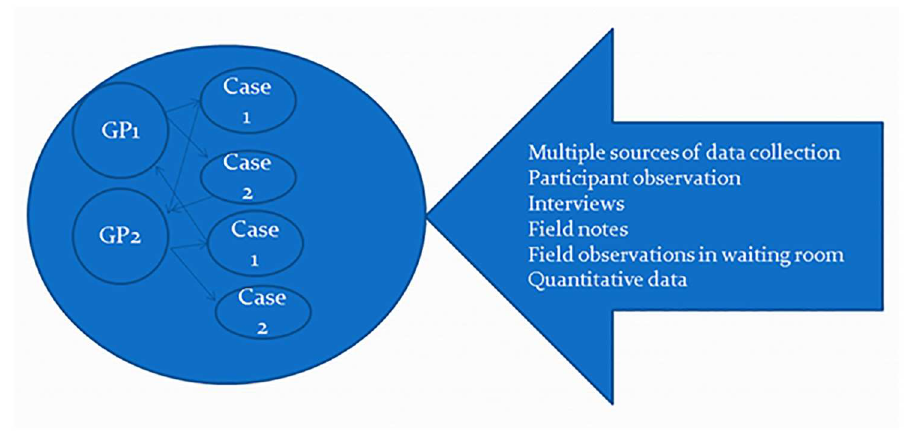
Fig 1. Embedded case study research